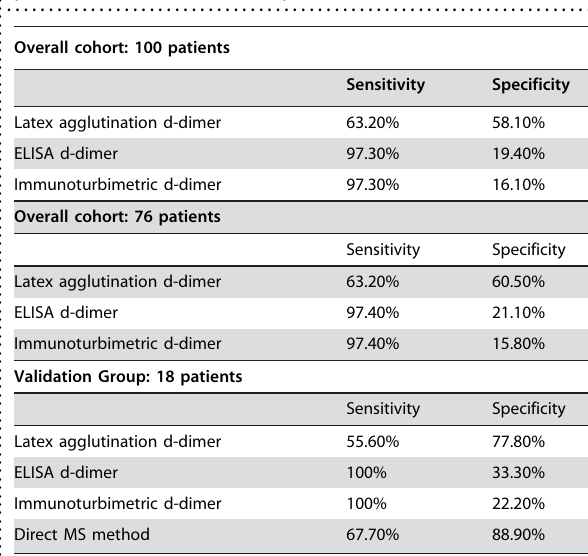
Table 2. Performance of the direct MS method of